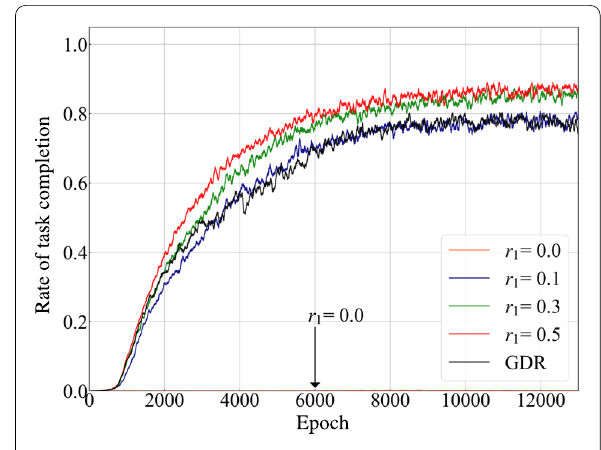
Figure 4 Rate of task completion